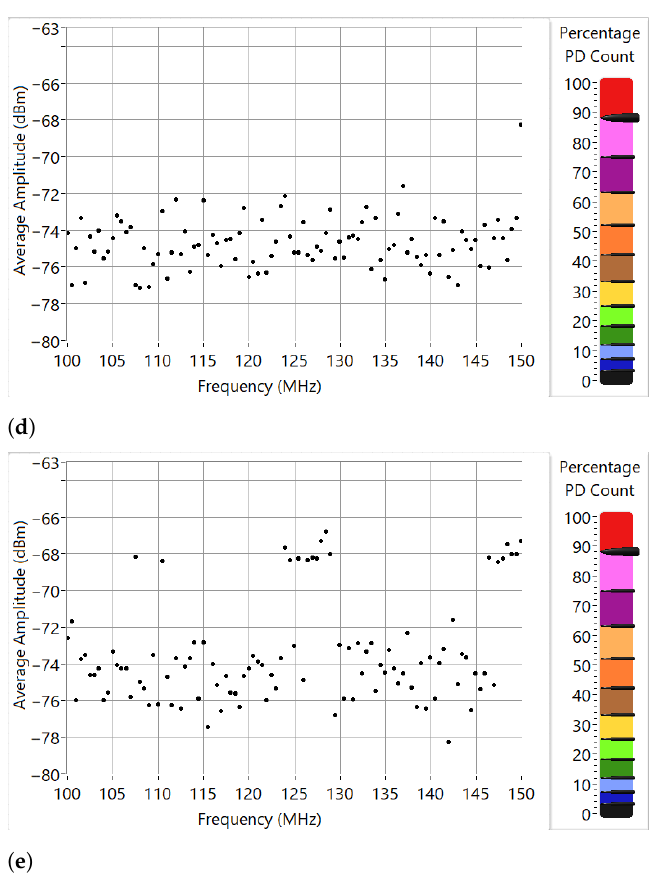
Figure 17. FRPD for different cases, from 100 to 150 MHz: ( a ) corona, ( b ) slot, ( c ) corona with slot,